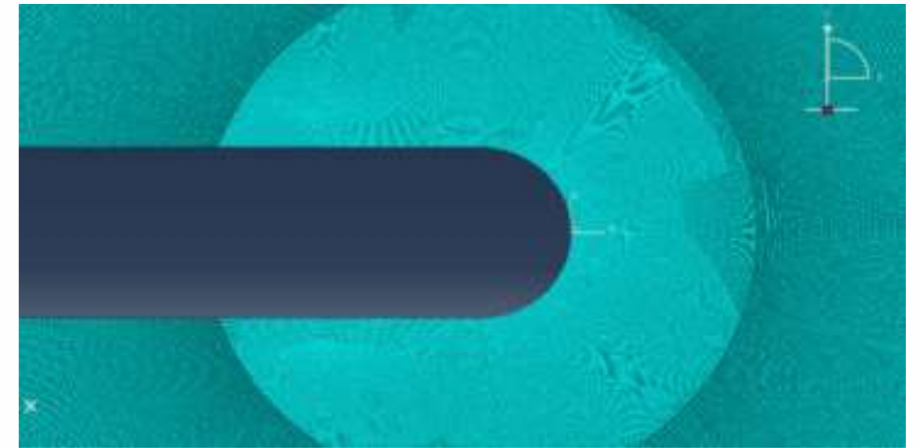
Figure 4. Mesh pattern in the vicinity of the U-notch tip.